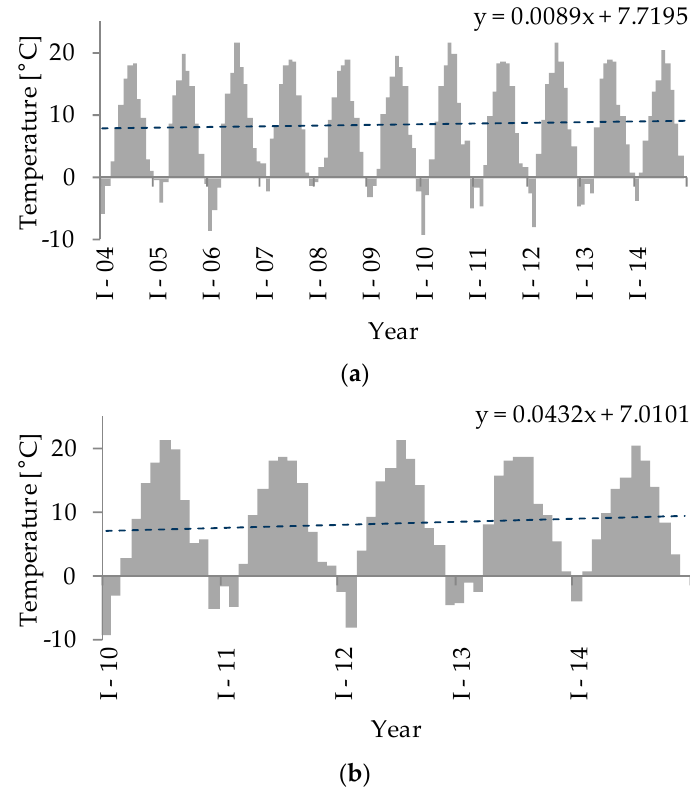
Figure 1. Monthly mean air temperature for two periods: ( a ) 2004–2014; ( b ) 2010–2014. The dashed line represents the trend line of changes in air temperature over time.